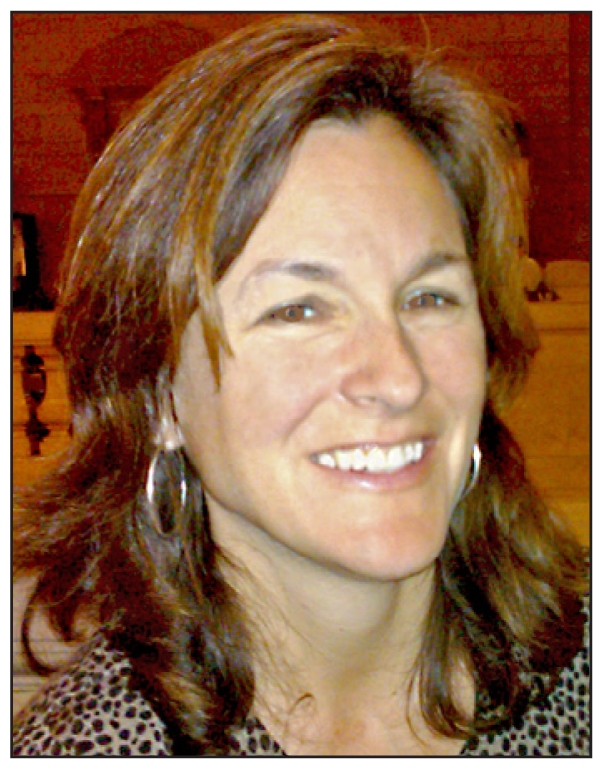
Tracey J. Woodruff